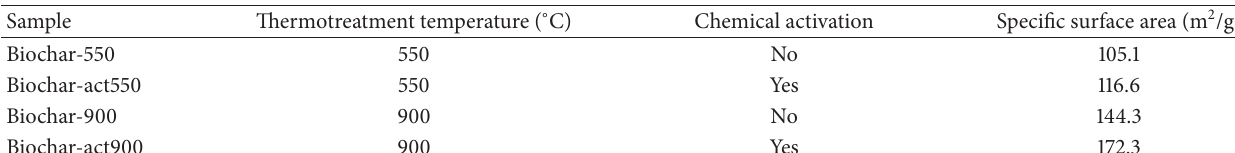
Table 1: The specific surface areas of biochars at different treatments.